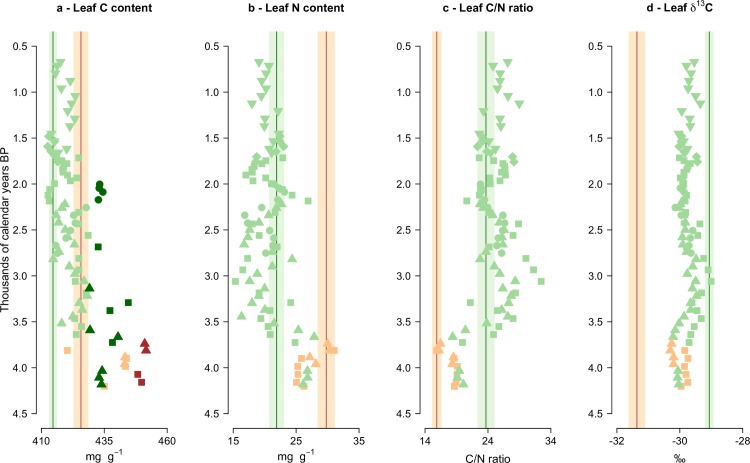
Changes in trait community weighted means (CWMs) through time (in thousands of calendar years before present) of the Holocene pollen-derived leaf trait records from five Fenland sites (circles = Murrow; squares = Redmere; diamonds = Swineshead; point-up triangles = Welney Washes 3rd peat; point-down triangles = Welney Washes 4th peat).Green and brown symbols indicate the predominance of herbaceous and woody taxa in the Holocene record, respectively. The means of the modern vegetation (i.e., plant-based data) are shown for herb (green vertical lines) and woody (brown vertical lines) fens. Shaded areas around the modern means depict their 95% confidence intervals. Darker-coloured symbols show Holocene samples significantly different from their equivalent (herbaceous or woody) modern vegetation means at p < 0.05 (one-observation t-tests).